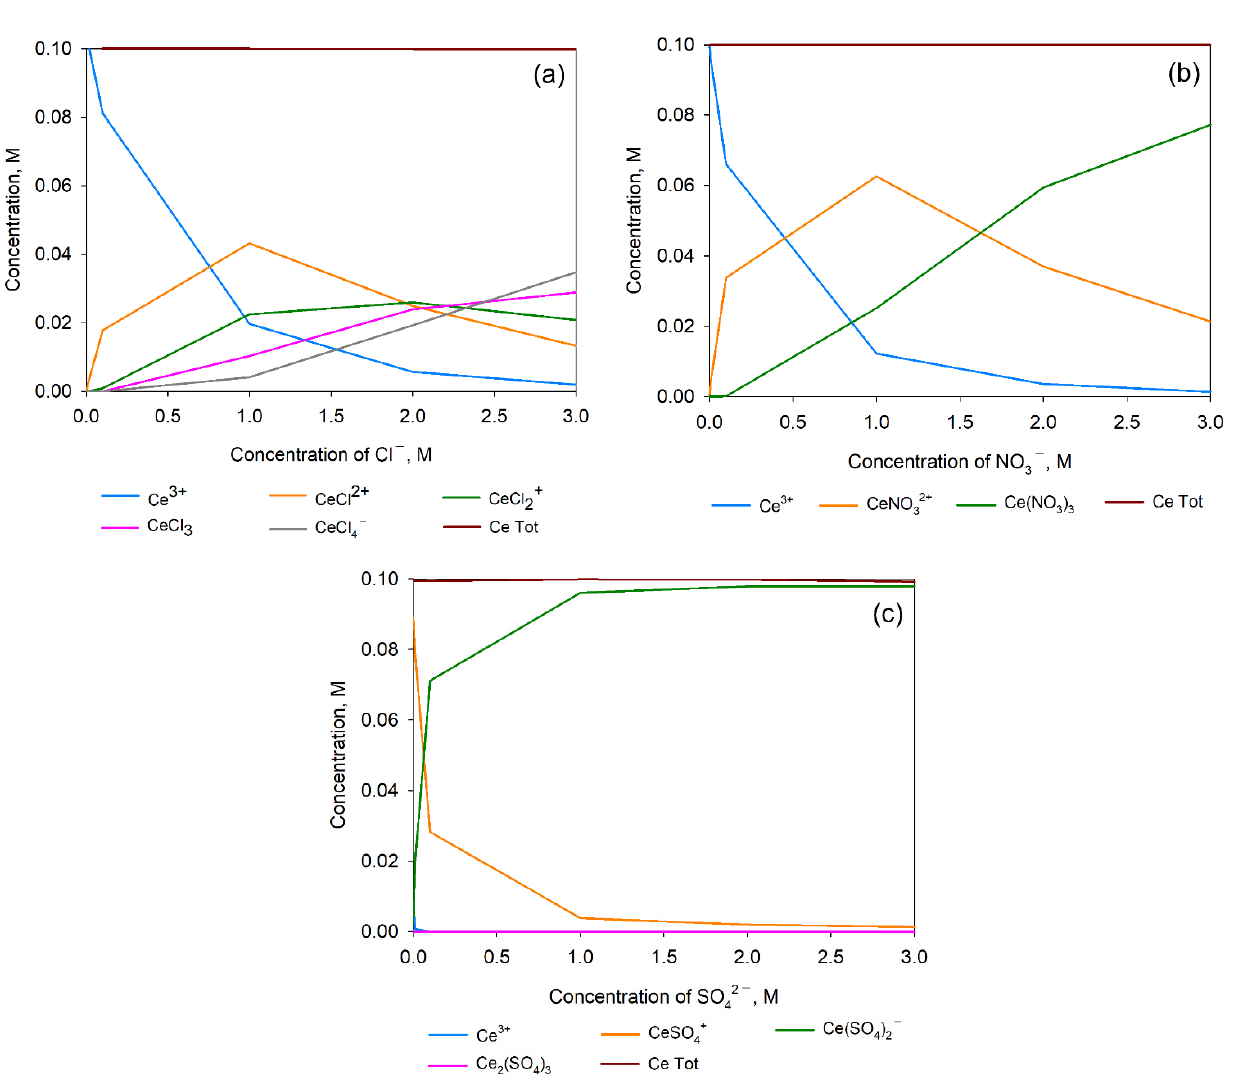
Figure 2. Cerium (III) speciation in ( a ) HCl; ( b ) HNO 3 ; and ( c ) in H 2 SO 4 systems.